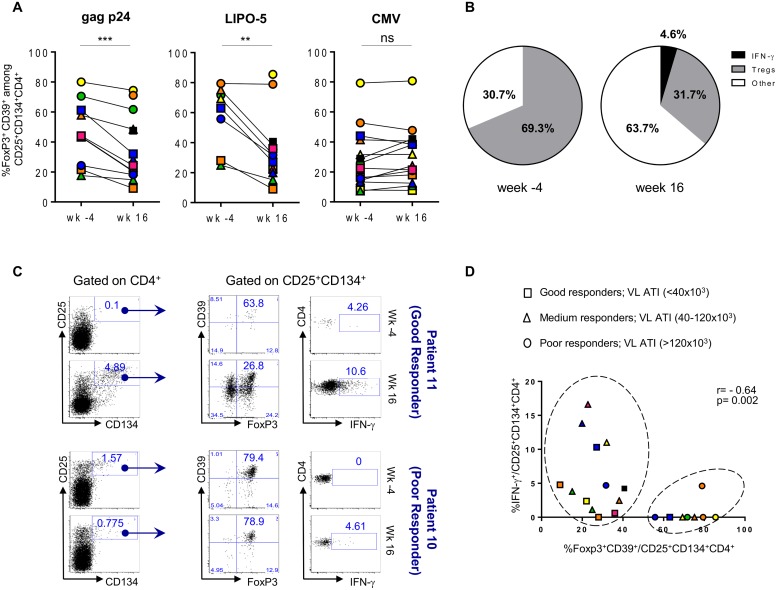
HIV-specific Tregs/Teffs ratio is affected by vaccination.(A) Gag p24-, LIPO-5- and CMV-Tregs responses prior and after vaccination (n = 14). (B) Pie chart showing LIPO-5-specific Tregs among LIPO-5-specific (CD134+CD25+) cells prior and after vaccination (n = 14). (C) Representative profiles after in vitro stimulation with LIPO-5 showing good and poor responder to vaccination (based on a viral load rebound). (D) Correlation between IFN-γ-producing and Tregs cells among LIPO-5-specific cells after in vitro stimulation. Data were analyzed by Wilcoxon matched-pairs signed rank test. *p < 0.05; **p < 0.01; ***p < 0.001. Spearman coefficient is indicated (r) as well as p value.